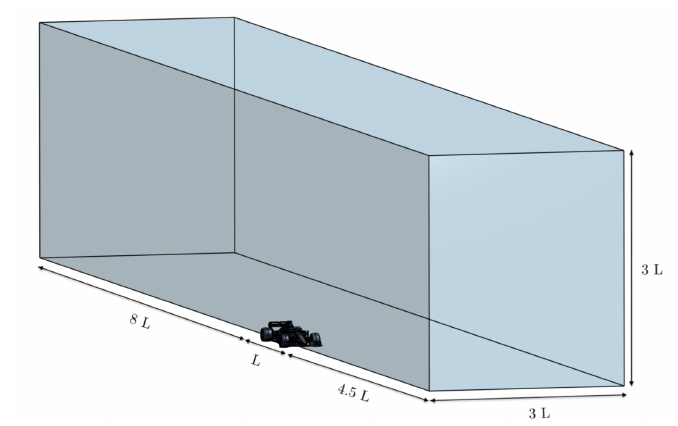
Figure 3. Fluid domain